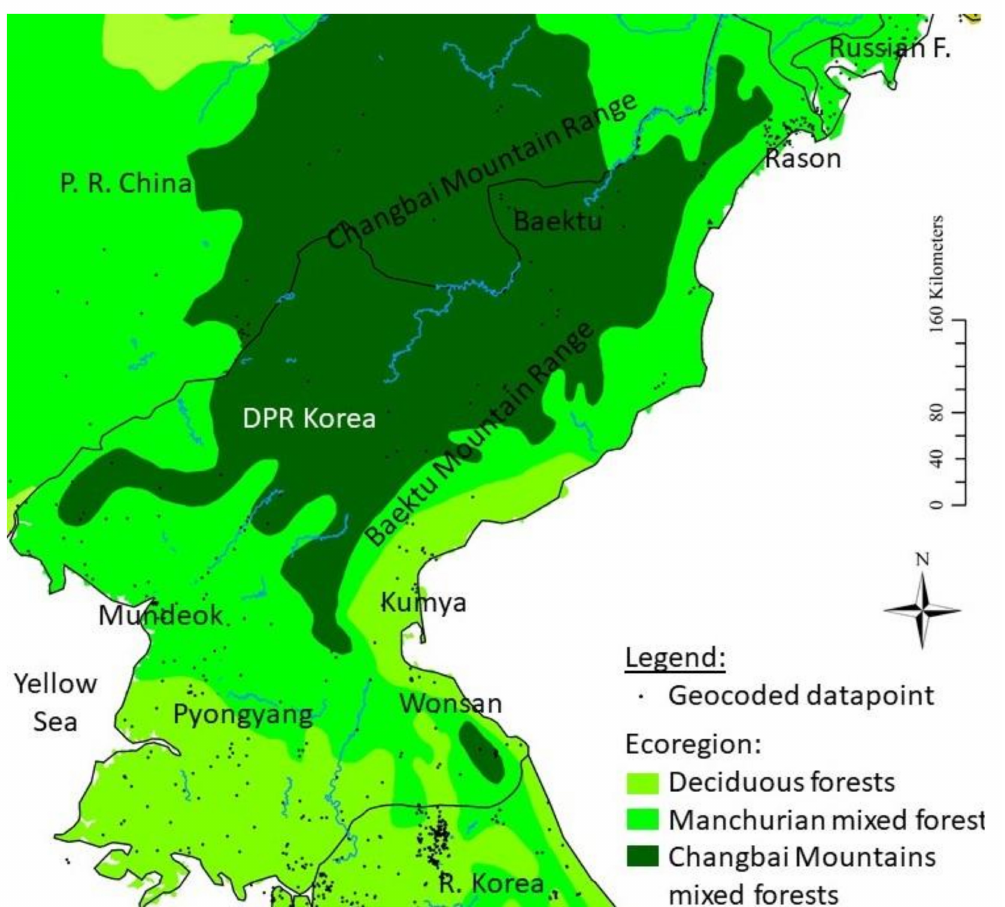
Figure 1. Map of survey locations and geocoded points for amphibian species presence in the Democratic People’s Republic of Korea. See the Supplementary Materials Tables for exact GPS coordinates for species in DPR Korea and Supplementary Materials Table S1 for all georeferenced datapoints for the species present in DPR Korea. The layer with ecoregions is attributed to [55]. Map created in ArcGIS 10.5 (ESRI; Redlands, CA,